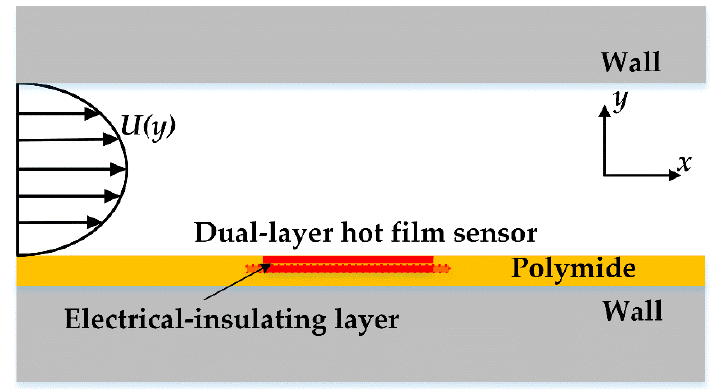
Figure 5. The schematic of simulation model.